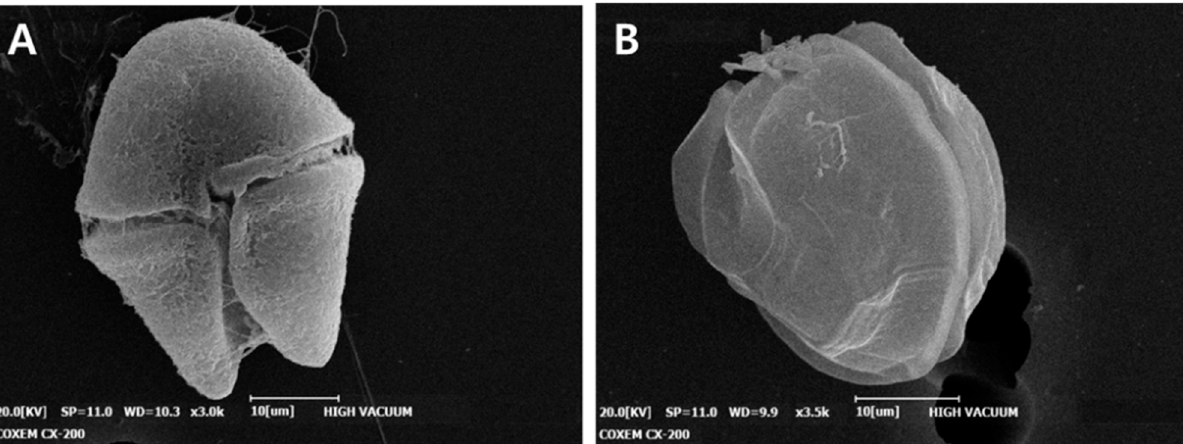
Figure 4. SEM images of LV-sIPN treated algae ( A ) Akashiwo sanguinea , ( B ) Alexandrium pacificum . Figure 5A represents the mean cell number of Ak. sanguinea and A. pacificum during treatment with LV-sIPN NP at 0 h and 24 h under light-to-dark conditions. After 24 h of NP treatment to Ak. sanguinea , the number of cells retained by 64%. The cells containing LV-sIPN NP among living cells were 95% of the total as shown in Figure 5B. While A. pacificum retained by 94% after LV-sIPN NP treatment, it was observed that only 7.93% of cells had uptake of LV-sIPN NP. Ak. sanguinea showed higher uptake ability compared to A. pacificum cells due to ornamented theca on the cell outer layer. We chose Ak. sanguinea for further laser treatment investigation due to higher NP uptake ability.